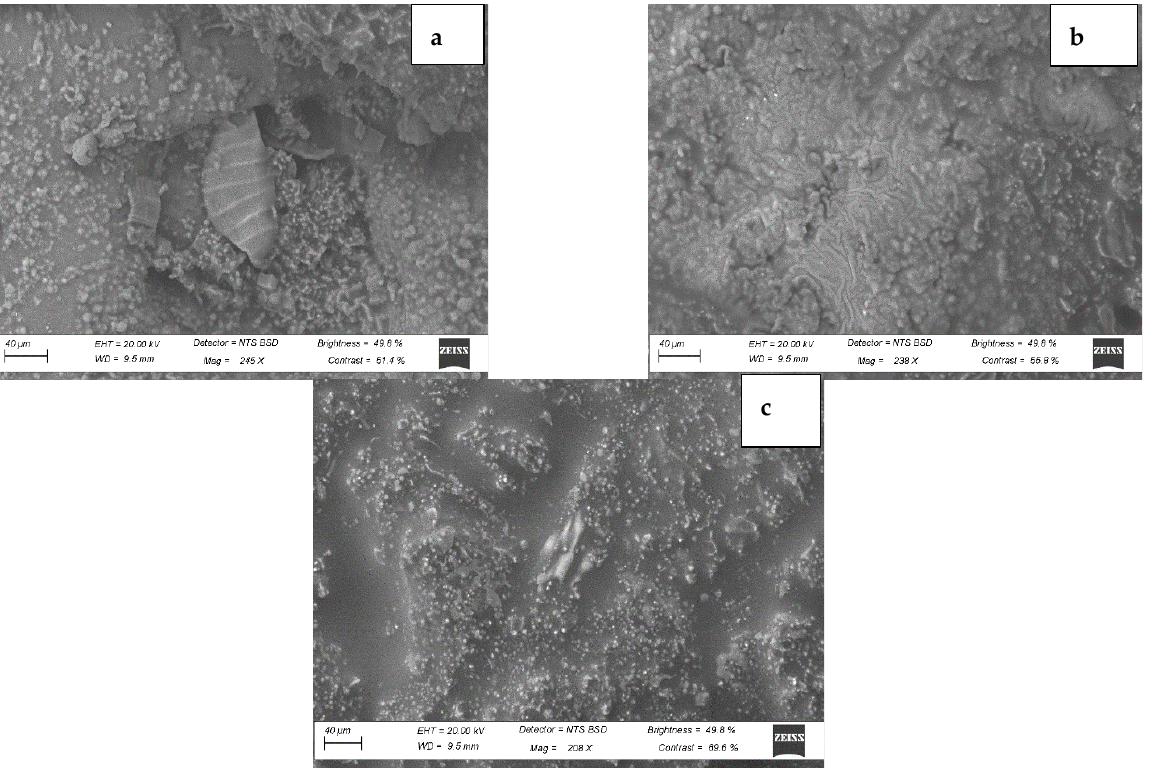
Figure 3 . Scanning Electron Micrograph of Bambara groundnut– Moringa oleifera snack bars (BAMOnut), Figure 3. Scanning Electron Micrograph of Bambara groundnut- Moringa oleifera snack bars (BA- showing ( a ) morphology of BAMOnut enriched with oats and 3% BAMOLP, ( b ); BAMOnut enriched MOnut), showing ( a ) morphology of BAMOnut enriched with oats and 3% BAMOLP, ( b ) BAMOnut with millet and 2% BAMOLP, ( c ); BAMOnut enriched with oats, millet and 5% BAM BAMOLP, (magni- enriched with millet and 2% BAMOLP, ( c ) BAMOnut enriched with oats, millet and 5% BAM fication ×245 for ( a ), ( b ): ×238, ( c ): ×206). All the micrographs are on a scale of 40 µm. BAMOLP, (magnification × 245 for ( a ), ( b ) × 238, ( c ) × 206). All the micrographs are on a scale of 40 µ m.